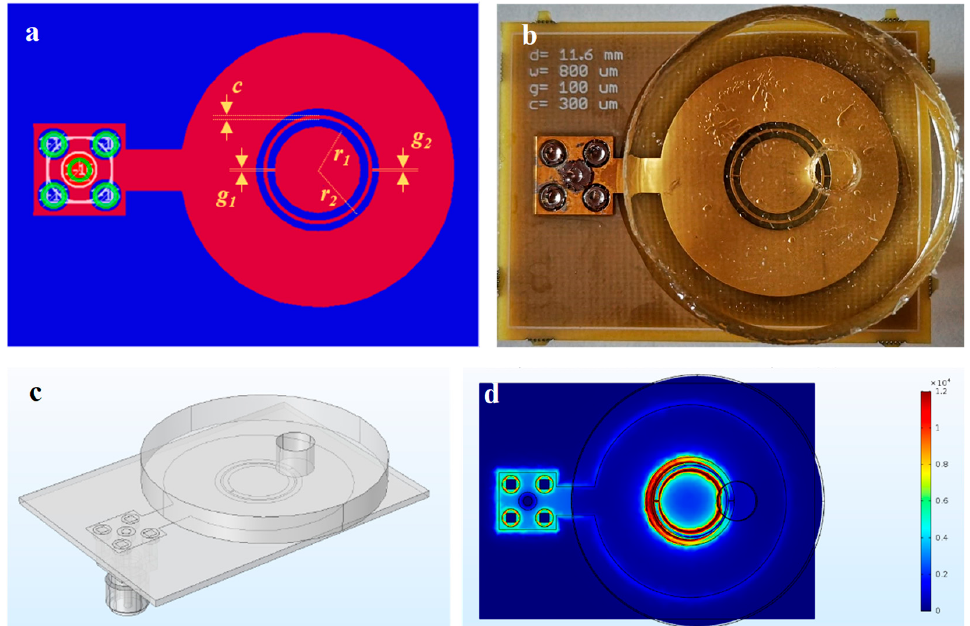
Figure 2. ( a ) CAD project of CDSRR. The upper metallized region is indicated in red, while the ground is represented in blue; vias are shown as green circular crowns. Particular features are indicated in yellow. ( b ) Device covered by a PDMS disk in which the well was realized. ( c ) 3D CAD drawn with Comsol© Multiphysics 5.3a for the whole device. ( d ) Module of the RF electric field in first mode for a slice adjacent to the interface between the resonator and the PDMS disk.